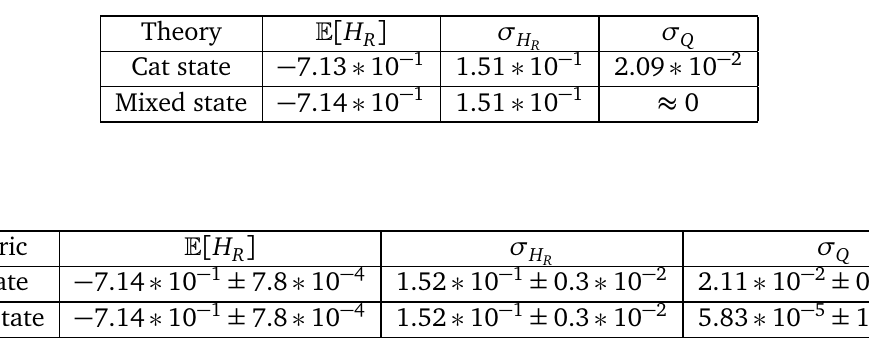
Table 1: Comparison between theoretical and numerical values for the mean and standard deviation of different quantities of